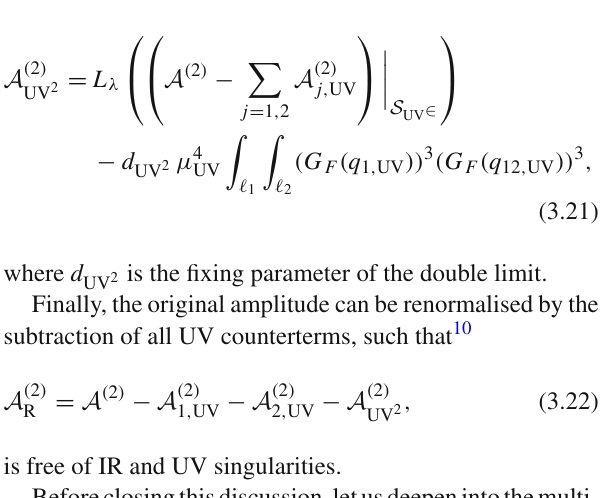
Fig. 4 Tree, one- and N F two-loop Feynman diagrams for γ ∗ → q ¯ q